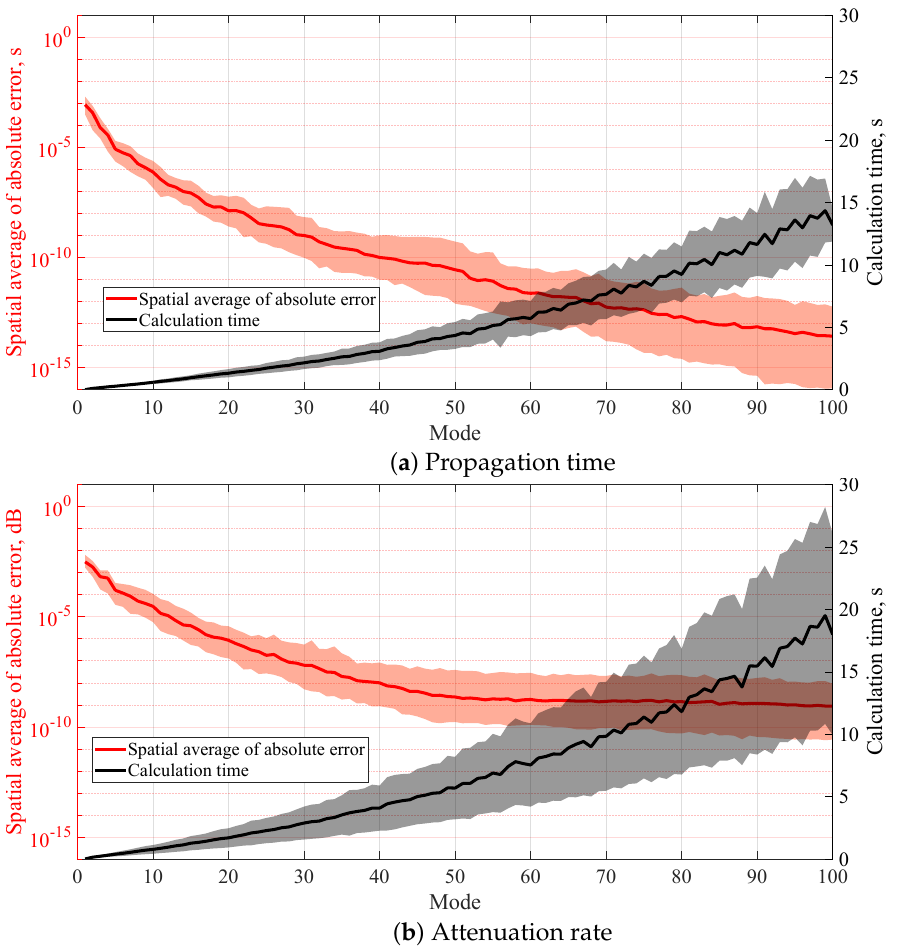
Figure 8. Spatial average of absolute error and calculation time ( p = r ). Here, the shaded regions of spatial averaged absolute error shows the range from the minimum to maximum values obtained for 50 runs with different random seeds. Shaded regions of calculation time shows the standard deviation obtained for 50 runs.